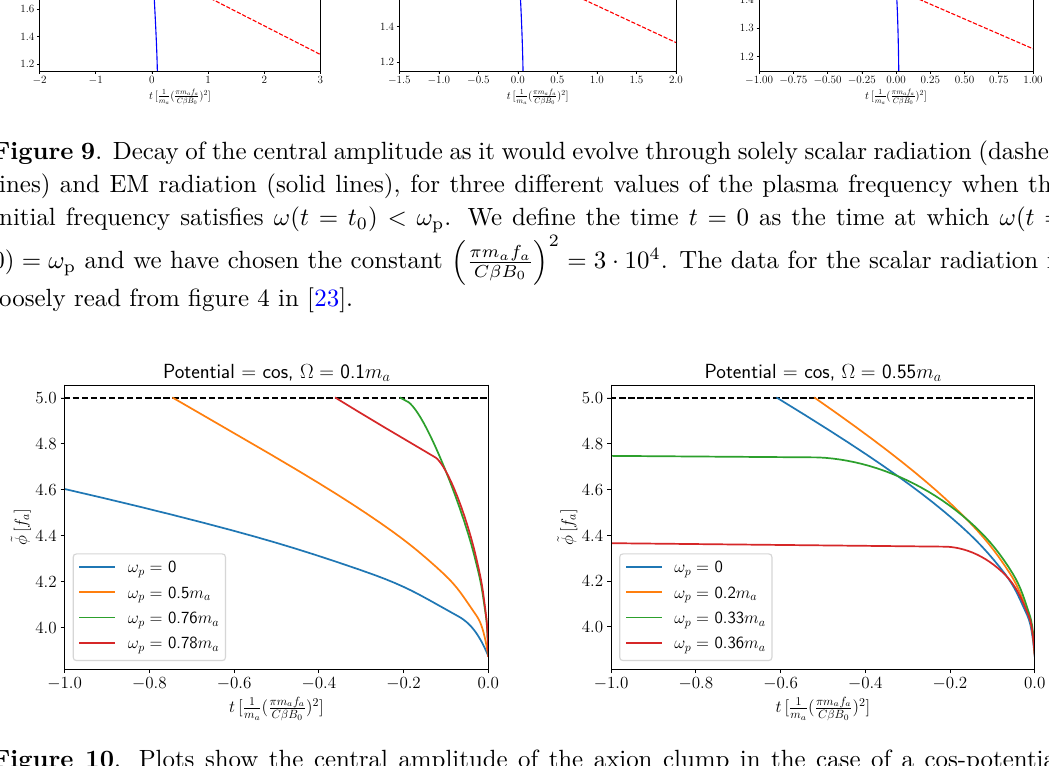
Figure 10 . Plots show the central amplitude of the axion clump in the case of a cos-potential for a few different values of the external magnetic field frequency Ω and the plasma frequency ω p . The dashed horizontal line represents the initial central amplitude of the clump ˜ φ ( t 0 ) = 5 f a with ω ( t = 0) = ω crit .